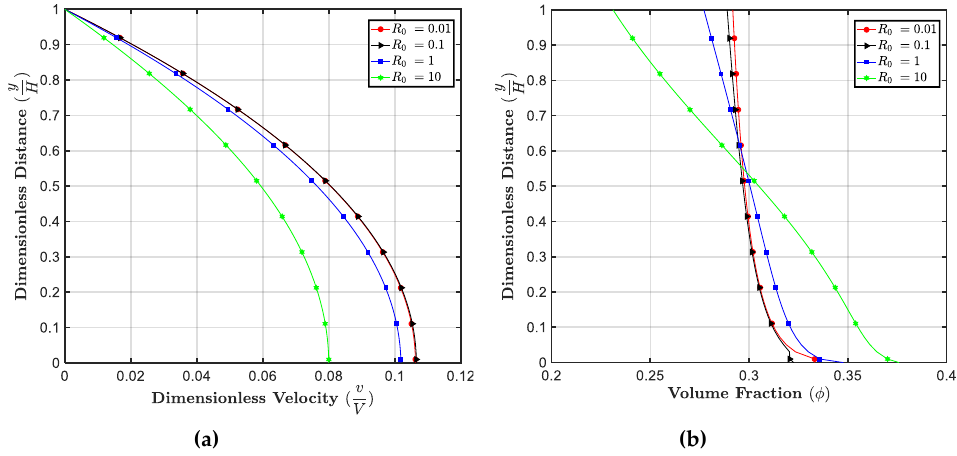
Figure 10. E ff ect of R 0 on ( a ) the velocity; and ( b ) the volume fraction profiles, with β = 1.82, φ avg = 0.3, R 1 = − 2.5, R 2 = 0.1, R 3 = 0.01, R 4 = 0.07, R 5 = 1.8, K c Figure 10. Effect of 𝑅 0 on ( a ) the velocity; and ( b ) the volume fraction profiles, with 𝛽 = 1.82, 𝜙 𝑎𝑣𝑔 = 0.3, 𝑅 1 = − 2.5, 𝑅 2 = 0.1, 𝑅 3 = 0.01, 𝑅 4 = 0.07, 𝑅 5 = 1.8, 𝐾 𝑐